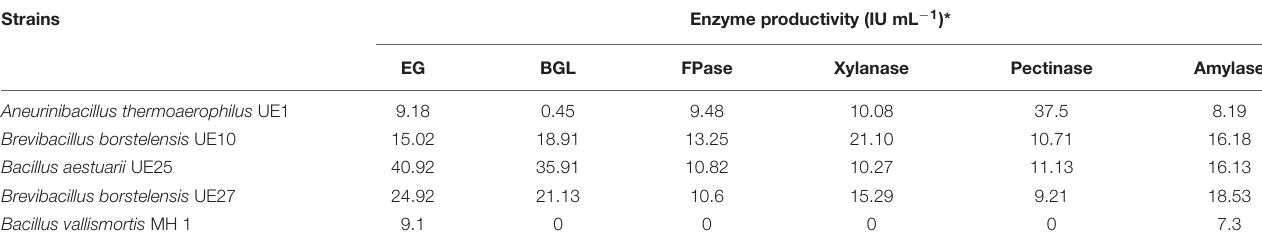
TABLE 1 | Endoglucanase (EG), β -glucosidase (BGL), filter paperase (FPase), xylanase, pectinase, and amylase production by bacterial strains.